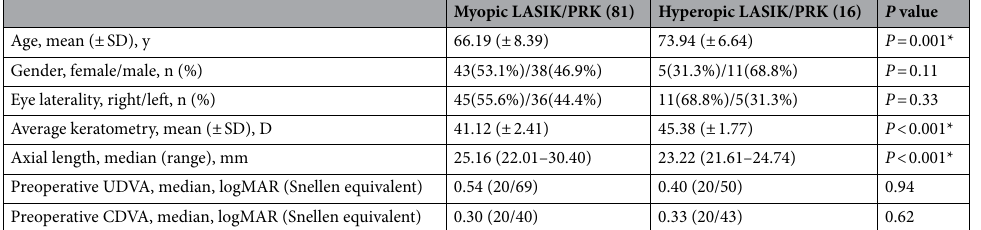
Table 1. Baseline characteristics of study participants. 97 eyes were included in the study with a mean age of 67 years old. 80 eyes (82.5%) had a history of myopic LASIK/PRK and 17 eyes (17.5%) had a history of hyperopic LASIK/PRK ( P < 0.001). LASIK laser in situ keratomileusis, PRK photorefractive keratectomy, UDVA uncorrected distance visual acuity, CDVA corrected distance visual acuity, logMAR log minimum angle of resolution. *Statistically significant.